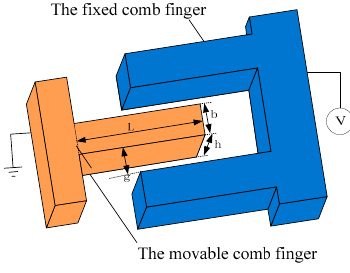
Figure 2. Illustration of a group of comb finger.